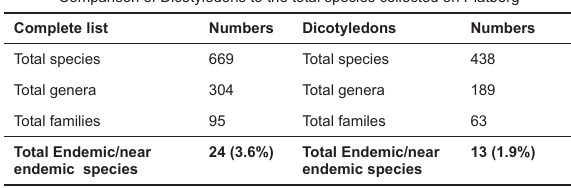
TABLE 5 Comparison of Dicotyledons to the total species collected on